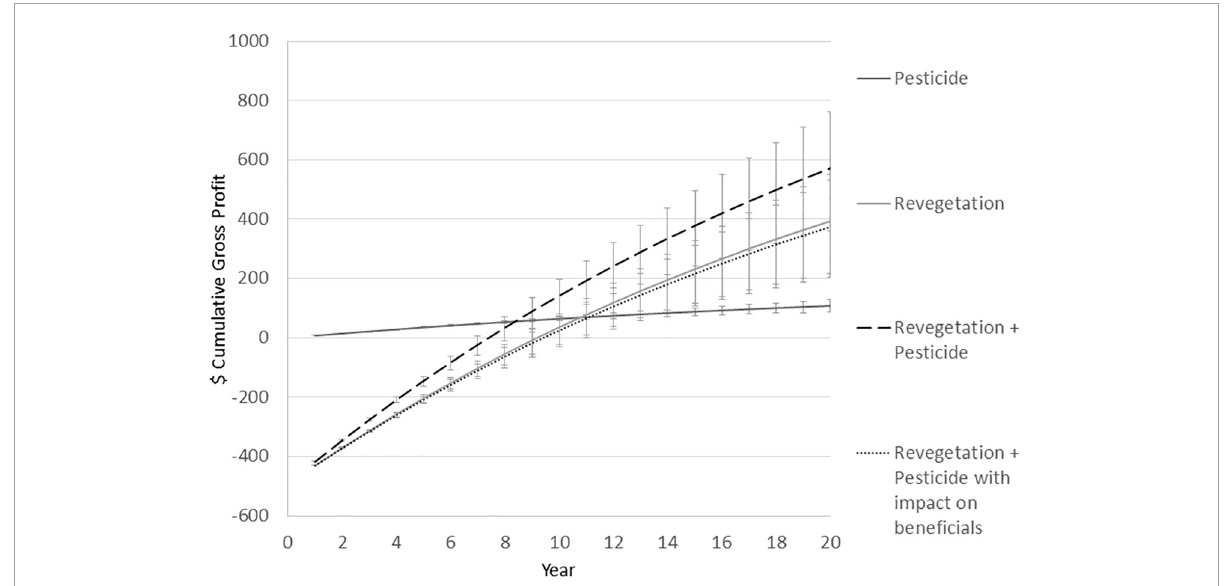
FIGURE7 Mean cumulative gross profit for canola achieved over time by independent management scenarios of pesticide and revegetation, compared to a scenario of revegetation with pesticide application where the pesticide has a negative impact on beneficials. Including a discount rate of 4% on the benefit and cost (error bars indicate a discount rate of 2 and